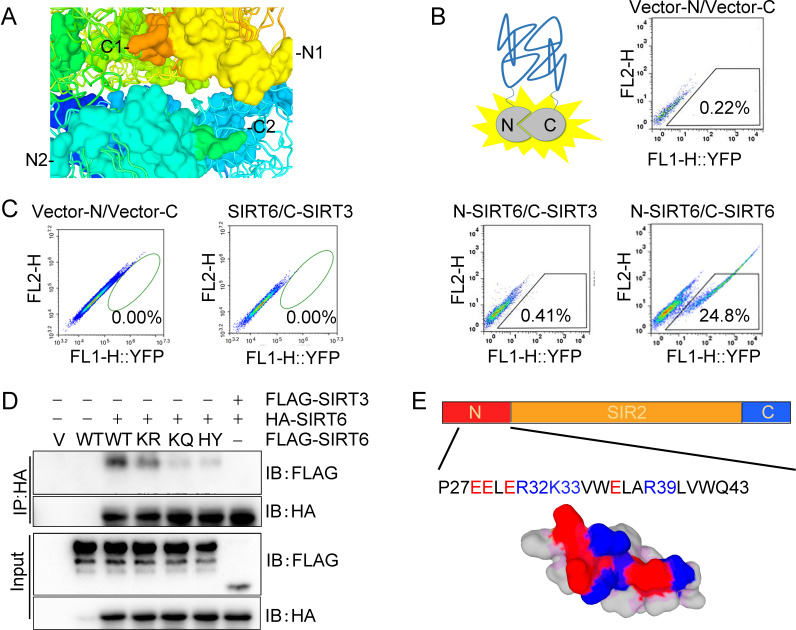
Polymerization of SIRT6.(A) Schematic of one putative DSB-binding pocket, consisting of two N-termini (yellow and aquamarine) and two C-termini (orange and lime green) of two adjacent SIRT6 hexamer molecules. (B) Schematic of the BiFC system (upper left) and yellow fluorescence detection in HEK293 cells co-transfected with empty vectors; N-SIRT6 and C-SIRT6; N-SIRT6 and C-SIRT3 via the BiFC system. (C) Yellow fluorescence detection in HEK293 cells ectopically expressing untagged SIRT6 and C-SIRT3. (D) Co-IP and western blot analysis of potential interaction between HA-SIRT6 and FLAG-SIRT6 WT, K33R, K33Q and H133Y. FLAG-SIRT3 was included as control. (E) Schematic of a SIRT6 N-terminal peptide showing the positively (blue) and negatively charged residues (red).